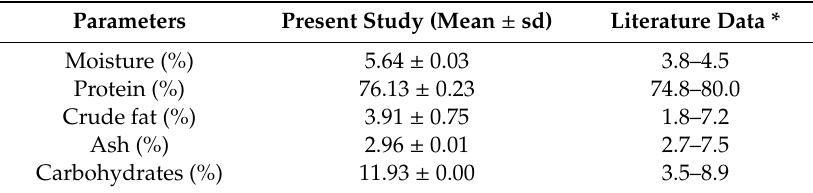
Table 1. Comparison of proximate composition of whey protein concentrate with literature. All values are reported in dry basis (%).